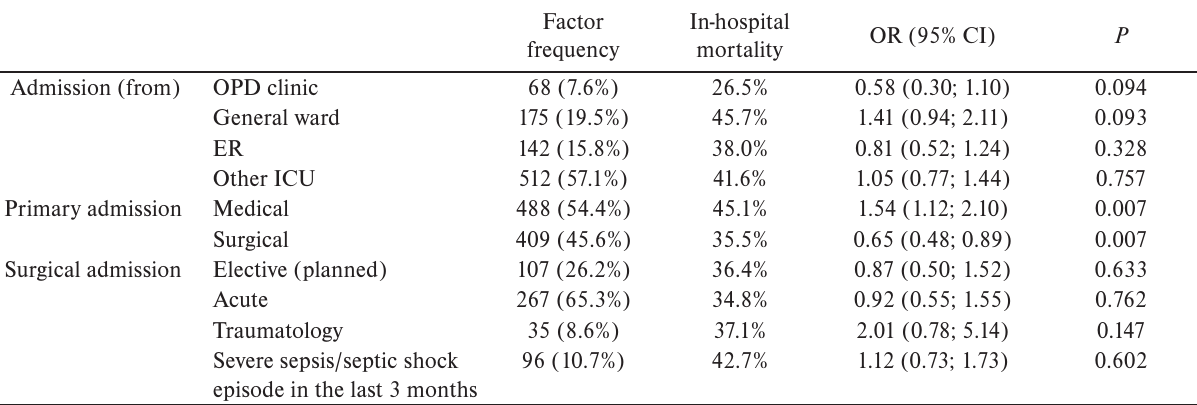
Table 7. Admission source, association with in-hospital mortality (adjusted to age and APACHE II).